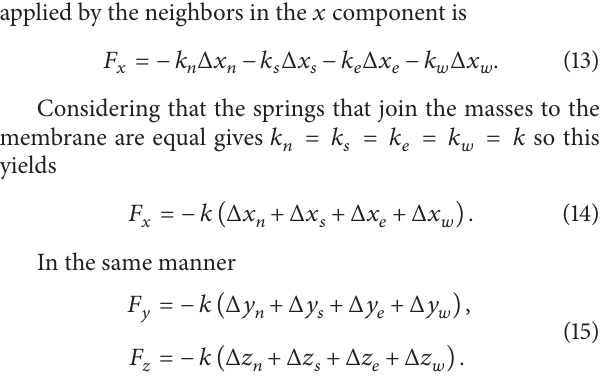
󳨀󳨀→ 󳨀→ 󳨀→ 𝑟 Δ𝑟 𝑟 𝑐 , 𝑤 , and 𝑤 represent the central